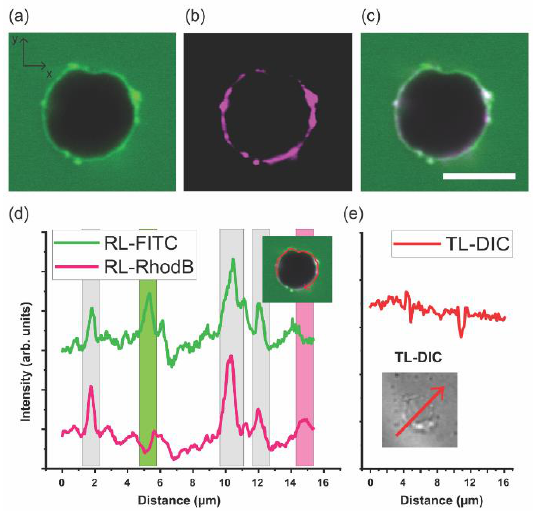
Figure 6. 2D cross-sectional CLSM images of mPEG- b -PCL / DPPC GHUVs in hypertonic media (80 mol% DPPC with respect to mPEG- b -PCL). (mPEG- b -PCL)-FITC and 16:0 Liss Rhod PE were used to tag polymer domains and lipid domains, respectively. The vesicle encapsulates MilliQ water and the external dispersion medium is introduced with 100 mM glucose solution. Scale bar: 5 µ m. ( a ) RL-FITC fluorescence in green (excitation laser at 488 nm / detection wavelength 400–544 nm) ( b ) RL-Rhod B fluorescence in magenta (excitation laser at 561 nm / detection wavelength 558–700 nm) ( c ) the merged image of both RL-FITC and RL-Rhod B channels ( d ) 1D profile of each channels along the vesicle membrane ( e ) TL-di ff erential interference contrast (DIC) image (inset) and its 1D profile. All images were obtained on Plan-Apochromat 63 × / 1.40 Oil DIC M27 objective